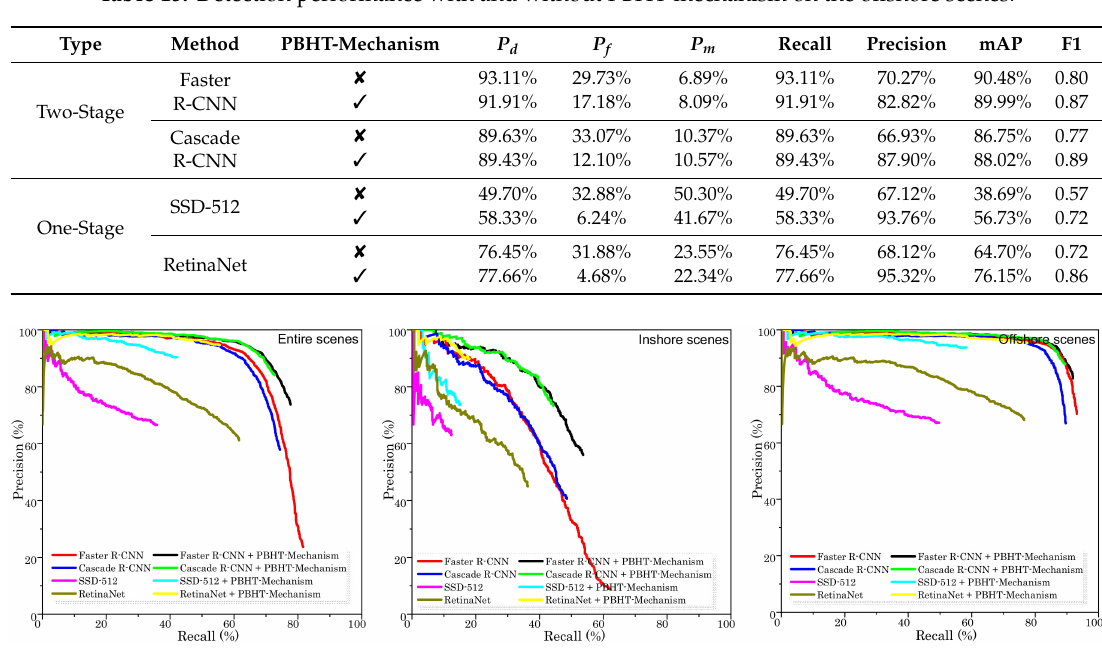
Figure 17. Precision-recall curves of di ff erent methods with and without